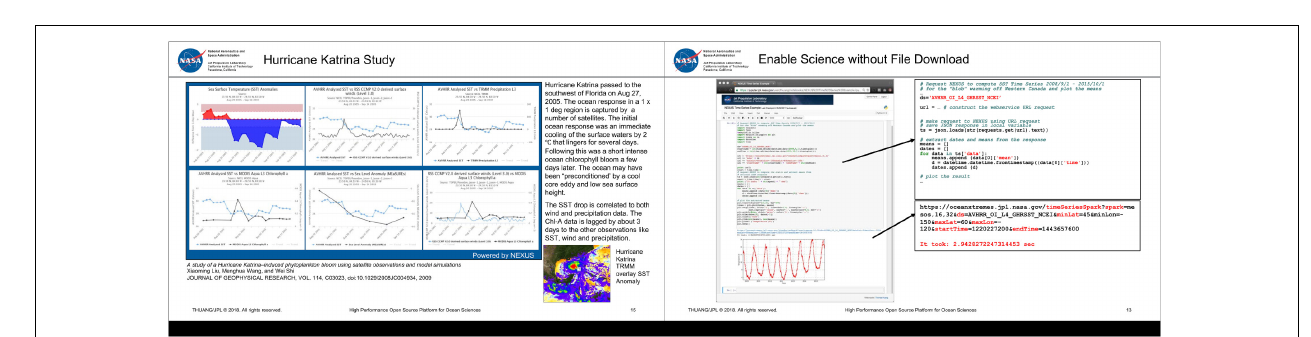
FIGURE 1 | An integrated data analytics platform.